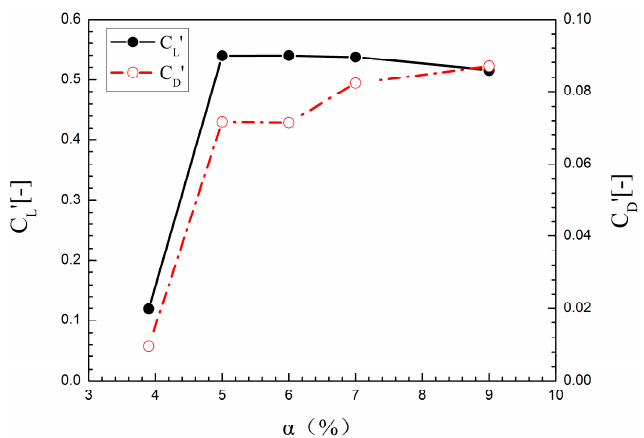
Figure 11. Comparison of central rotating shaft fluctuation amplitude with respect to different values of α .